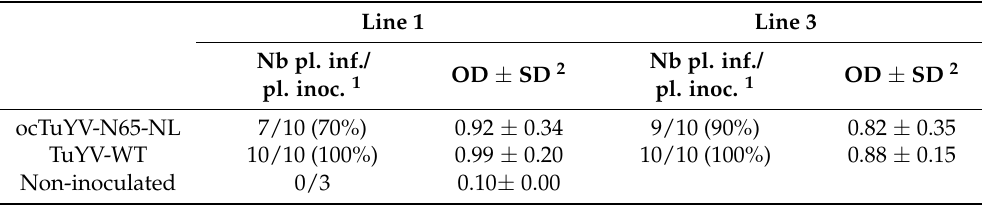
Table 3. Detection by double antibody sandwich (DAS)-ELISA of TuYV-N65-NL in upper non- inoculated leaves of two lines (1 and 3) of transgenic Nicotiana benthamiana 35S:C66-NL.